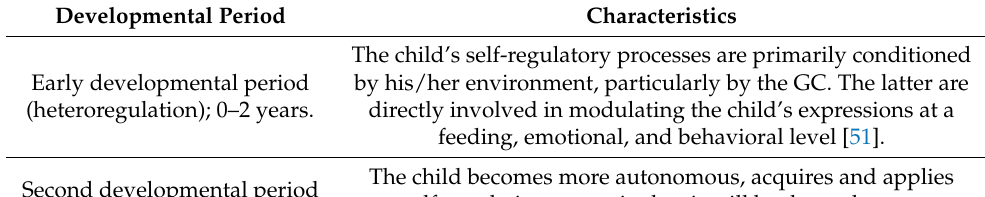
Table 1. Developmental